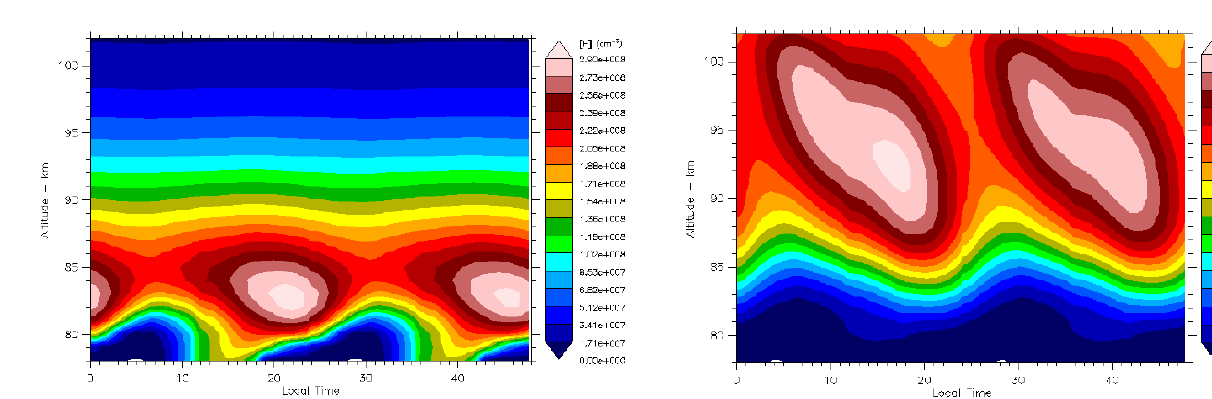
Fig. 3a. Local time variation of O for model days seven through eight in the April equatorial region. The effects of the diurnal tides are evident. The tidal phases compare well with the SABER O ob- servations by Smith et al. (2010) and Russell et al. (2005).